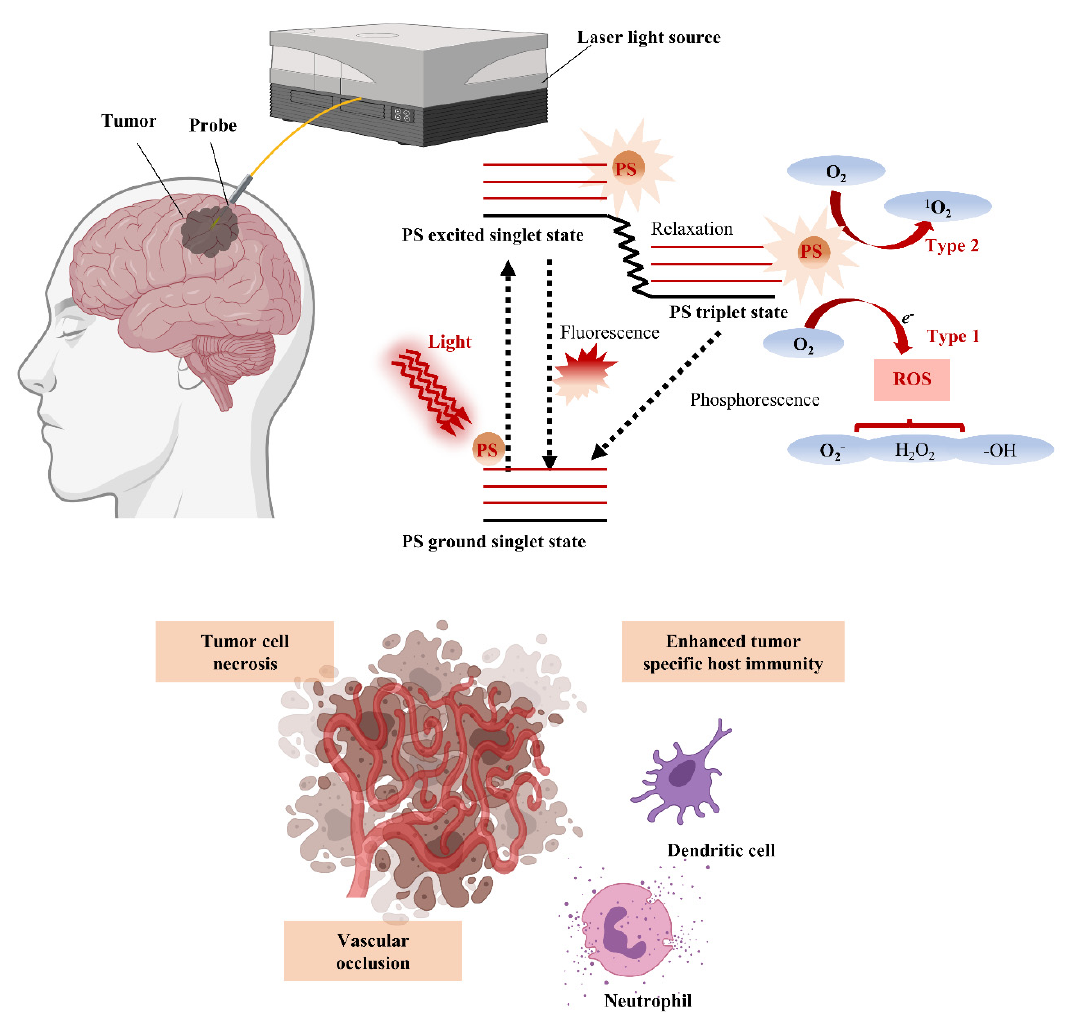
Figure 1. Schematic illustration of photodynamic therapy (PDT) for GBM treatment with energy diagram of the oxygen dependent response. If the photosensitizer (PS) in the ground singlet state is excited by the light wavelength, then the PS in the excited singlet state can convert to the excited triplet state via intersystem crossing. In the presence of molecular oxygen, the PS in the triplet state can undergo a Type 1 or Type 2 redox reaction, producing reactive oxygen species (ROS) that cause tumor cell necrosis, vascular occlusion, and tumor-specific host immunity.